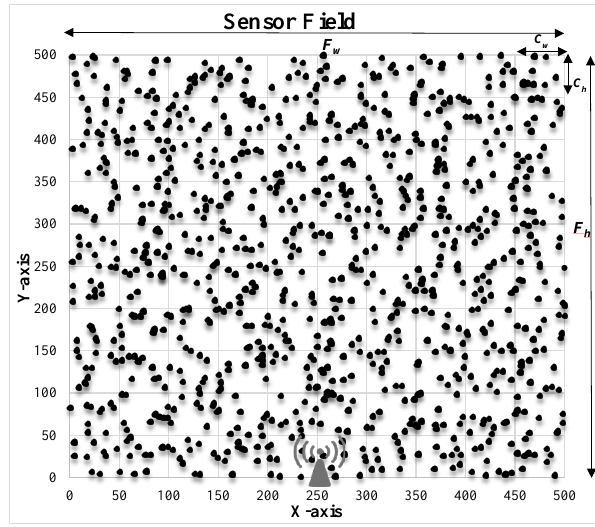
Figure 7. Sensor field.